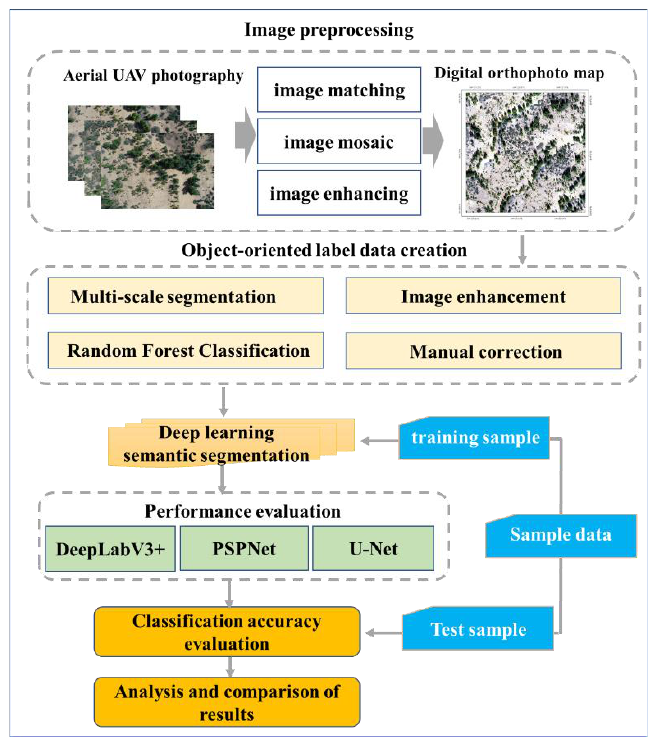
Figure 2. PV/NPV estimation architecture.